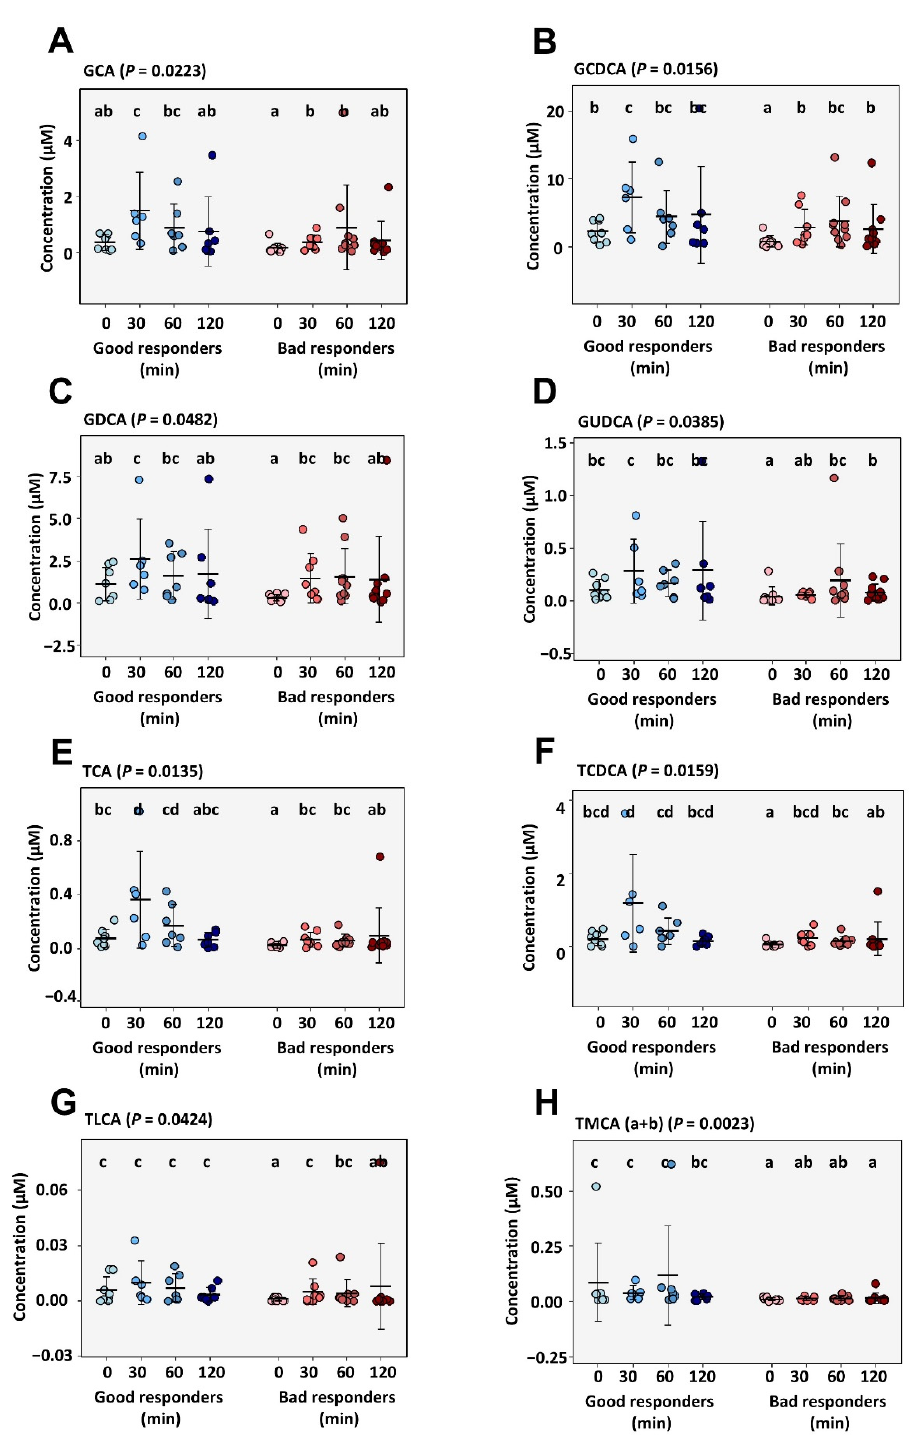
Figure 5. Serum bile acid levels in response to a standardized meal test after 0, 30, 60 and 120 min of ingestion in good and bad responders. ( A – H ) depicts concentrations of individual bile acid species measured in serum. Significance calculated by Kruskal–Wallis test with pairwise post-hoc Dunn’s test. Significance calculated by Kruskal–Wallis set with post-hoc pairwise Dunn’s test. Different letters (a–d) between values signify significant differences. GCA, glycocholic acid; GCDCA, glycochenodeoxycholic acid; GDCA, Glycodeoxycholic acid; GUDCA, Glycoursodeoxycholic acid; TCA, Taurocholic acid; TCDCA, Taurochenodeoxycholic Acid; TLCA, Taurolithocholic acid; TMCA ( α + β ), Tauro-muricholic